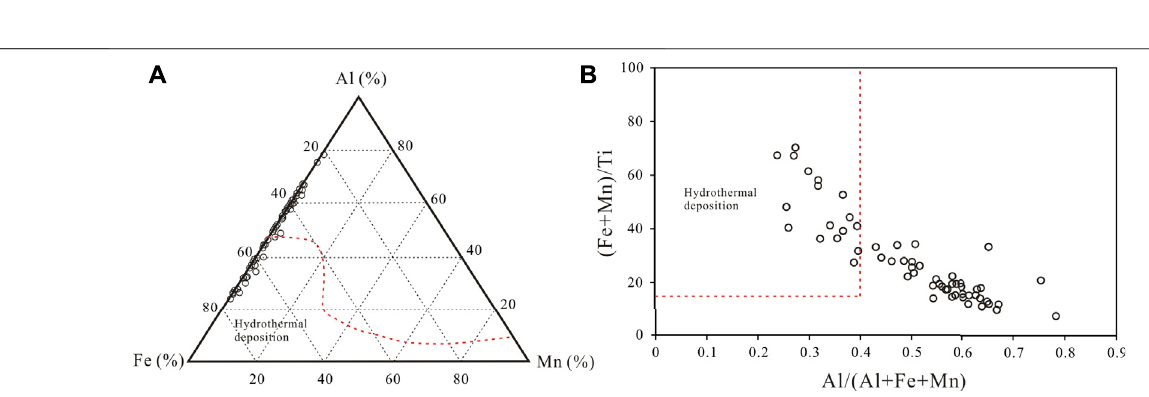
FIGURE 7 | The crossplot of SiO 2 and TiO 2 in the Chang 7 black shale, Ordos Basin.